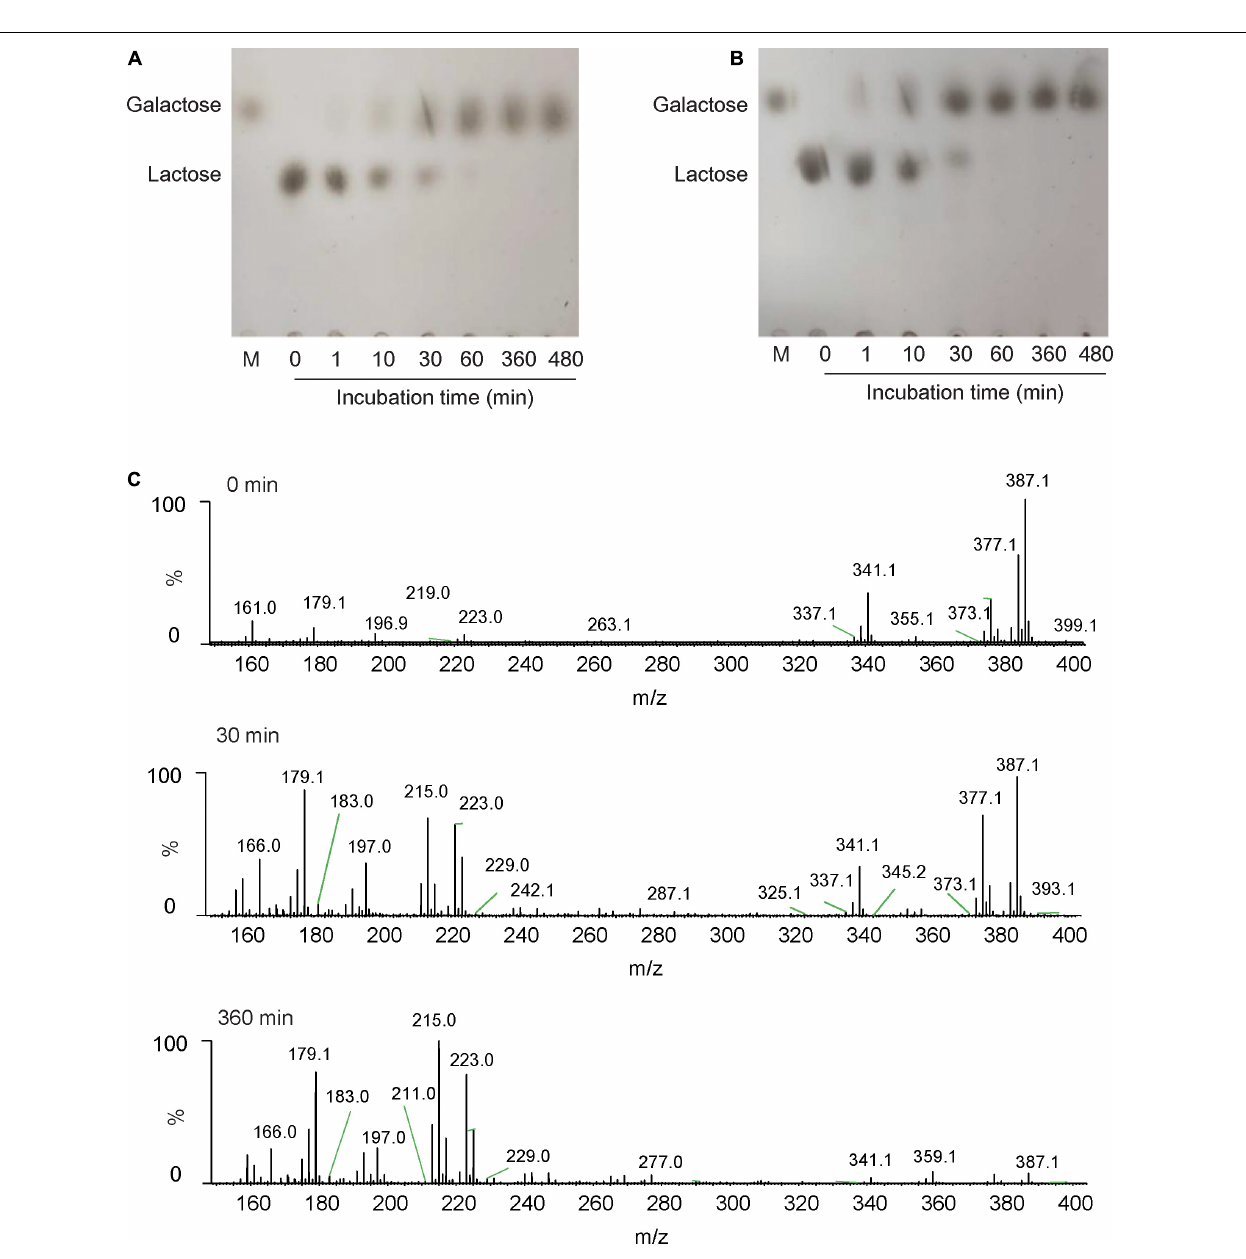
FIGURE 5 | The analysis of action patterns and reaction products for Gal42. (A) Thin-layer chromatography (TLC) analysis of Gal42-hydrolyzed lactose. (B) TLC analysis of Gal42-hydrolyzed milk. Lane M, standard galactose. (C) Electrospray ionization–mass spectrometry (ESI-MS) analysis of reaction products for Gal42 after 0-, 30-, and 360-min